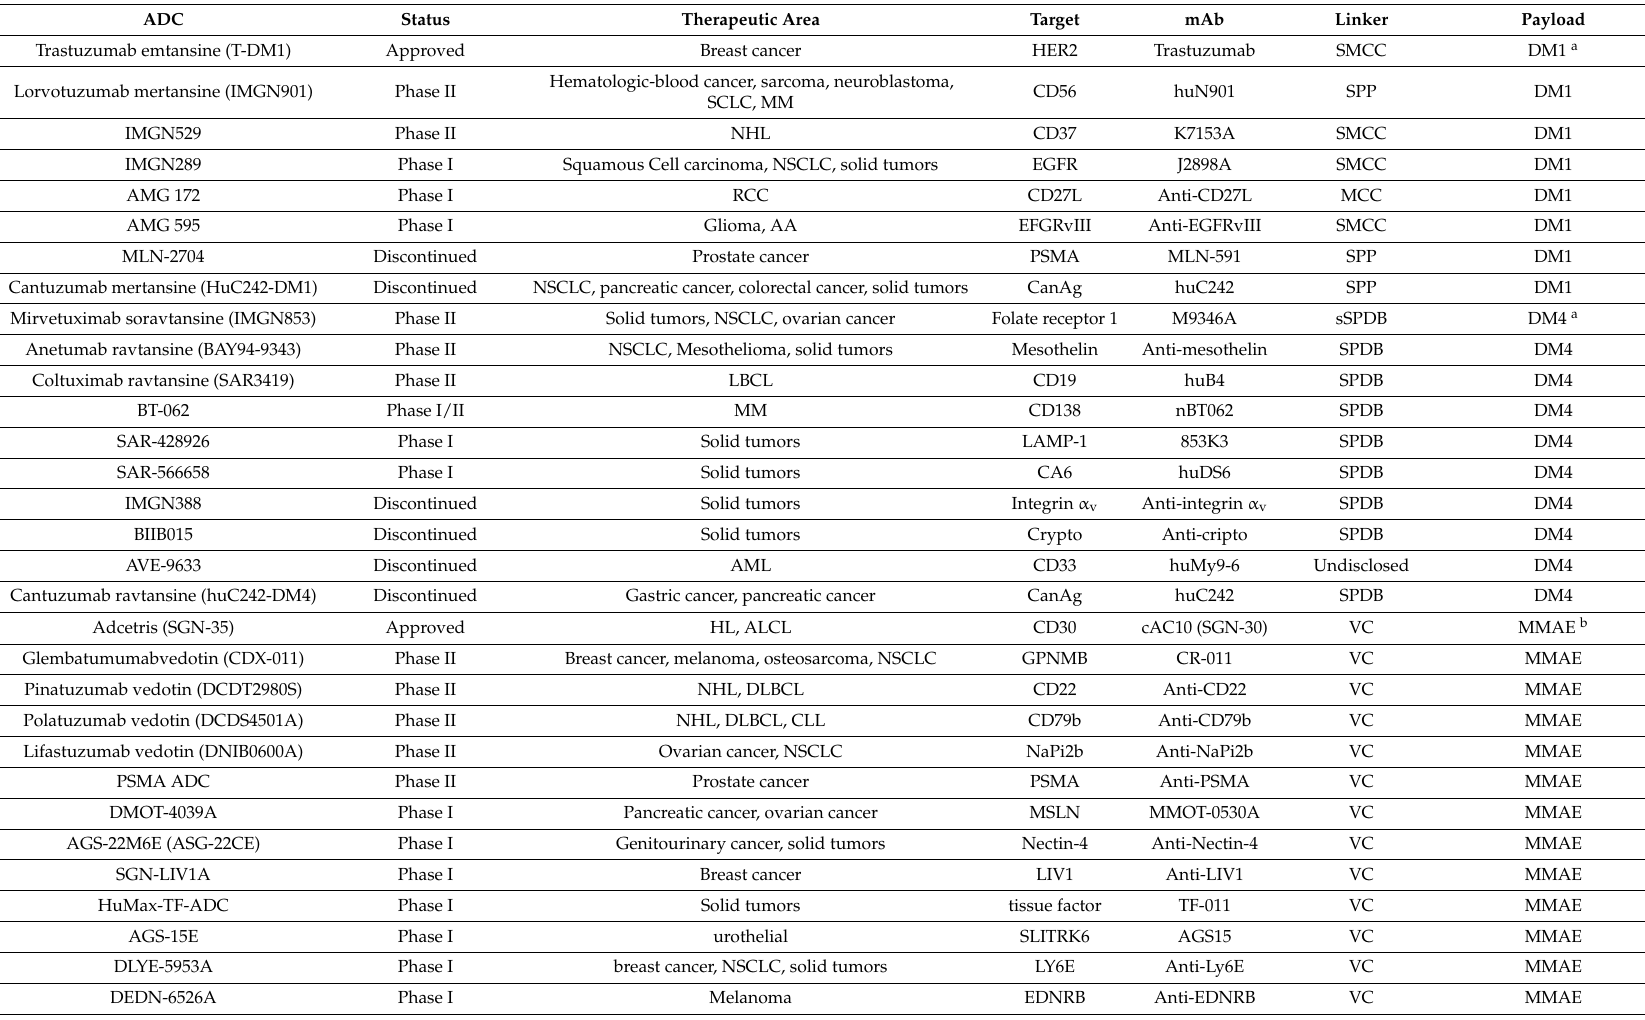
Table 2. Summary of the preclinical and clinically tested ADCs employing the maytansinoid, dolastatin, cryptophycin hemiasterlin, tubulysin and taxol as payloads. ADC